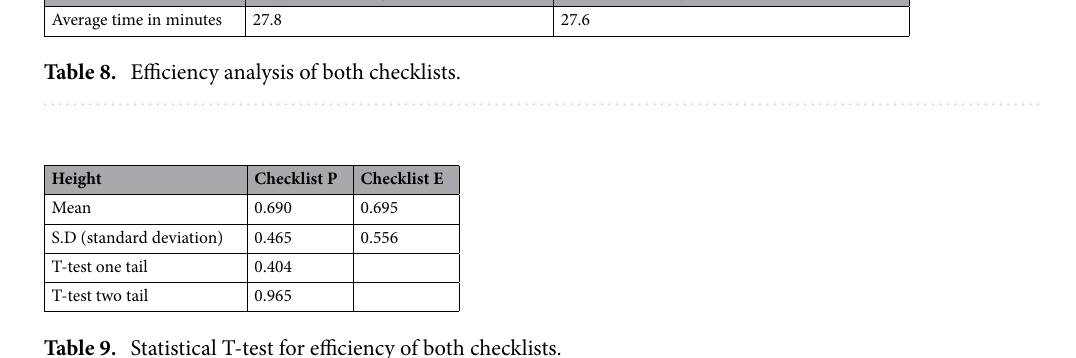
Table 9. Statistical T-test for efficiency of both